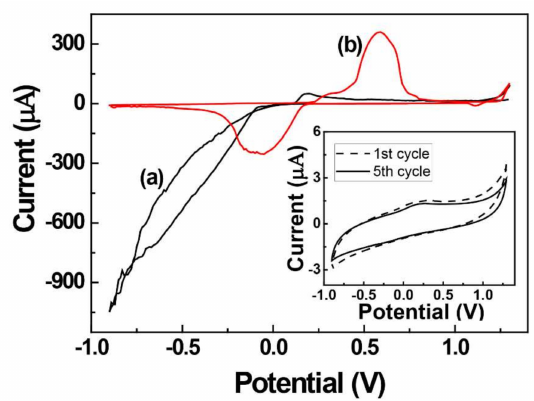
Figure 1. Cyclic voltammograms of the 0.5 wt / vol % of AgCl / PEI-decorated electrode in 0.1 M PBS (pH 7.0) recorded at a scan rate of 50 mV s − 1 for ( a ) the first and ( b ) the fifth cycle. The inset figure shows the PEI-coated electrode under the same experimental parameter conditions.